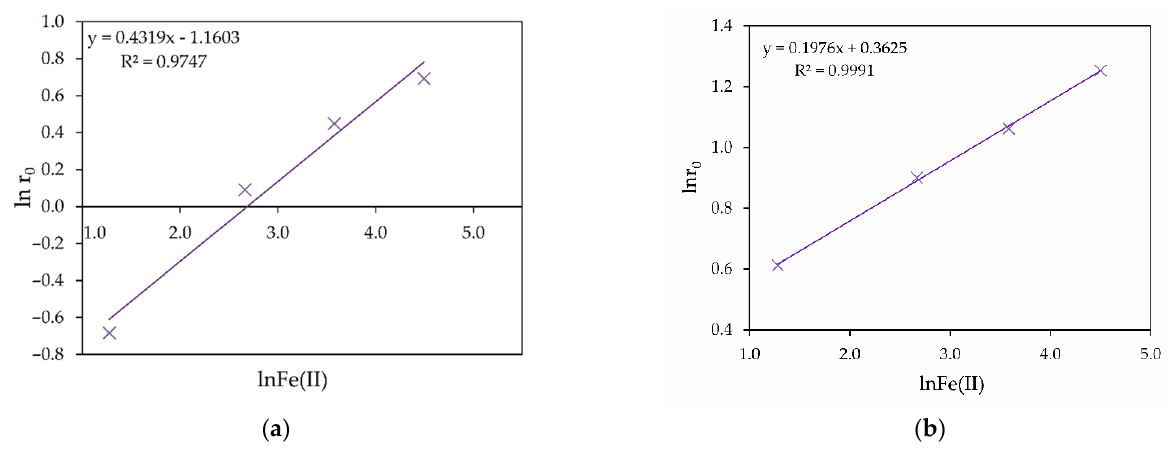
Figure 8. Dependence of lnr 0 on lnFe (II) without ( a ) and with ( b ) Cu (II). The experimental reaction order relative to the concentration of Fe (II) ions is 0.43 for the H 3 AsO 3 -Fe 2+ -H 2 SO 4 system and 0.20 for the H 3 AsO 3 -Fe 2+ -Cu 2+ -H 2 SO 4 system (Figure 8a,b, respectively). The difference in the reaction orders relative to iron was caused, apparently, by the catalytic influence of the Cu (II) ions on the Fe (II) ion oxidation in the H 3 AsO 3 -Fe2 + -Cu 2+ -H 2 SO 4 system (Equations (11)–(14)). A graphical determination of the partial order relative to the Cu (II) ions concentration is given in Figure 9.